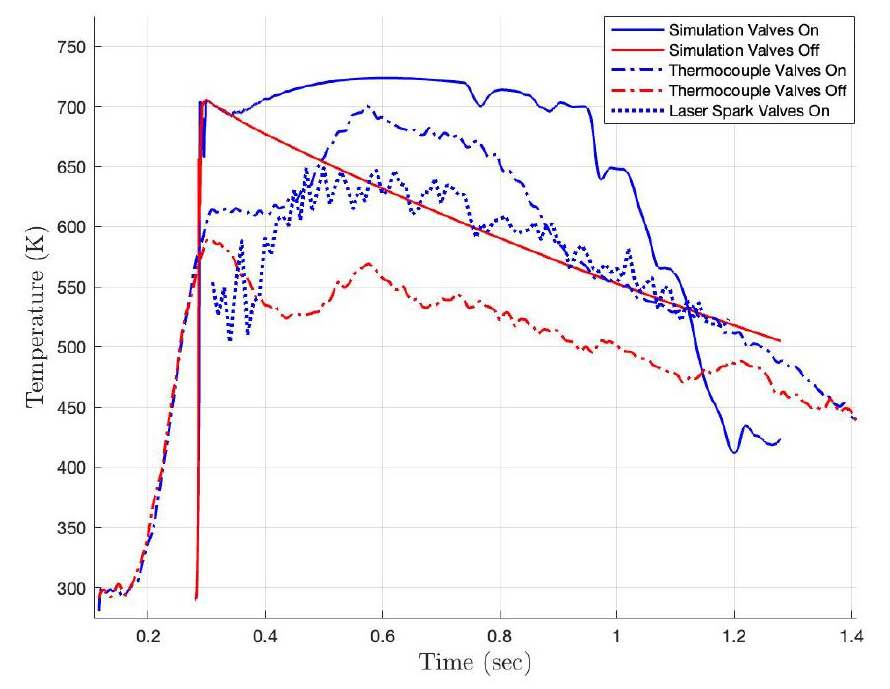
Figure 17. Simulated temperature dynamics for half geometry domain at P 0 = 1.6 bar and T 0 = 700 K compared to laser spark data and thermocouple probe measured temperature with assumed recovery factor of r =